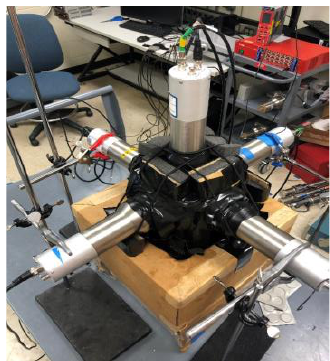
Fig. 2. Three-dimensional neutron scatter camera prototype. The PMT coupled to the bottom face is not visible as it is resting inside of the cardboard box support. Photo courtesy of the